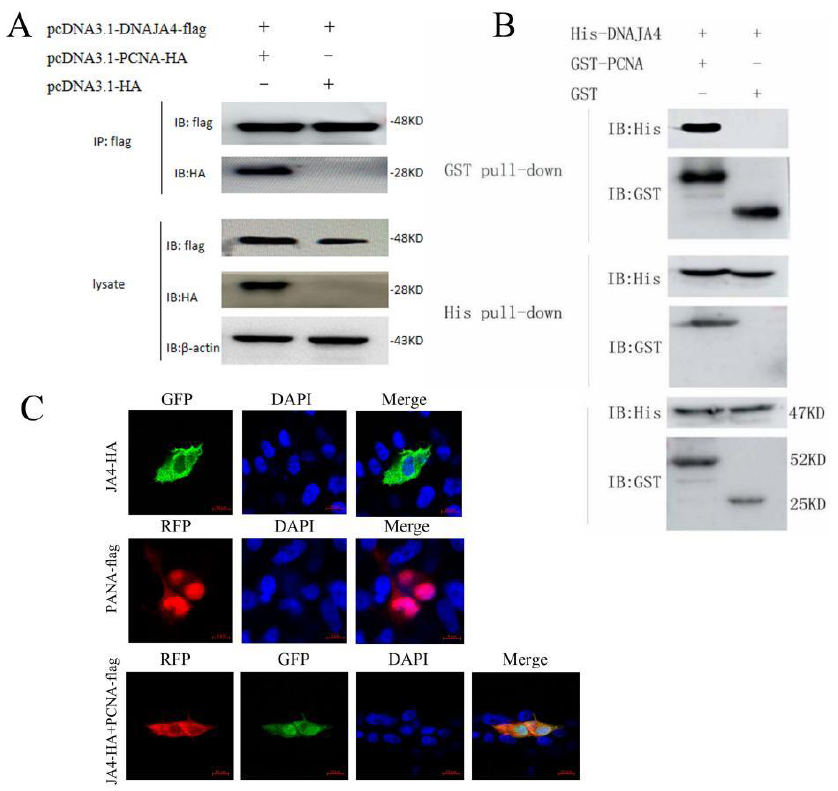
Figure 6. Interaction between EPC DNAJA4 and CGSIV PCNA: ( A ) Co-IP detects the interaction between EPC DNAJA4 and CGSIV PCNA. CO-IP was immunoblotted with anti-Flag antibody and anti-HA antibody. ( B ) His – pulldown and GST – pulldown verified that EPC DNAJA4 interacts with CGSIV PCNA. ( C ) Immunofluorescence detection shown of DNAJA4-HA and PCNA-Flag co-localization in EPC.